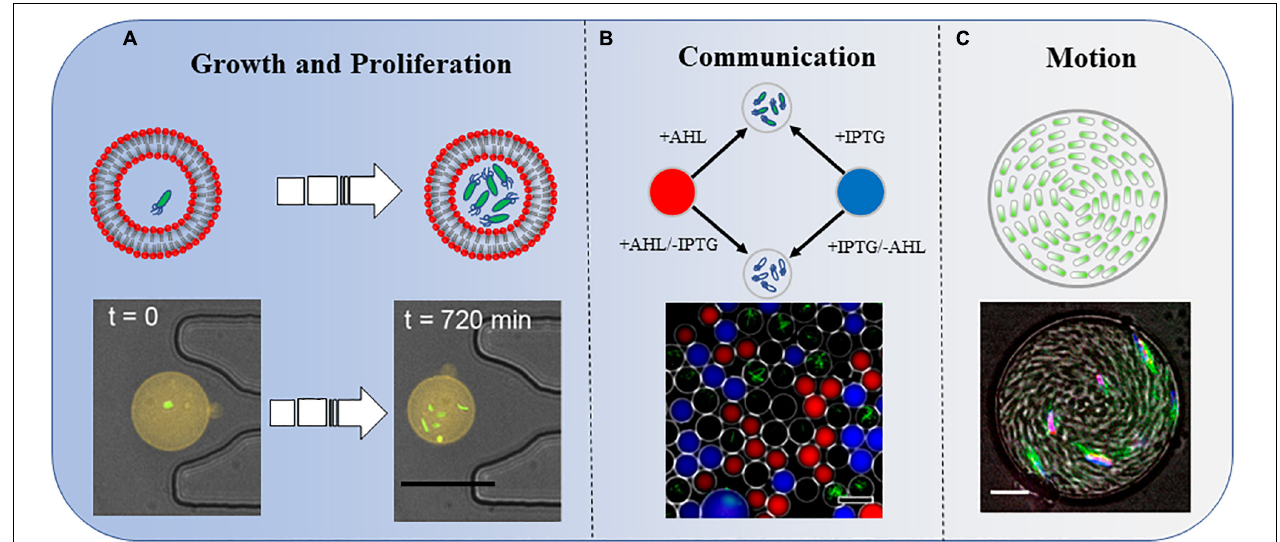
FIGURE 1 | Three types of bacterial behaviors in a confined space. (A) Growth and proliferation. Bacterial growth and proliferation in phospholipid vesicles. The shrinkage of the space reduces the growth and proliferation speed of bacteria compared with those in the same culture medium in a non-enclosed space. Scale bar, 25 µ m. Adapted with permission from Juskova et al. (2019). Copyright 2019, American Chemical Society. (B) Communication. Bacteria sense IPTG and QS molecule AHL diffused into the droplets. The combined effects of these two molecules induce the bacteria to produce GFP. Scale bar, 50 µ m. Adapted with permission from Weitz et al. (2014). Copyright 2014, American Chemical Society. (C) Motion. A concentrated suspension of bacteria forms a vortex motion in the droplet. Scale bar, 10 µ m. Adapted with permission from Lushi et al. (2014). Copyright 2014, National Academy of